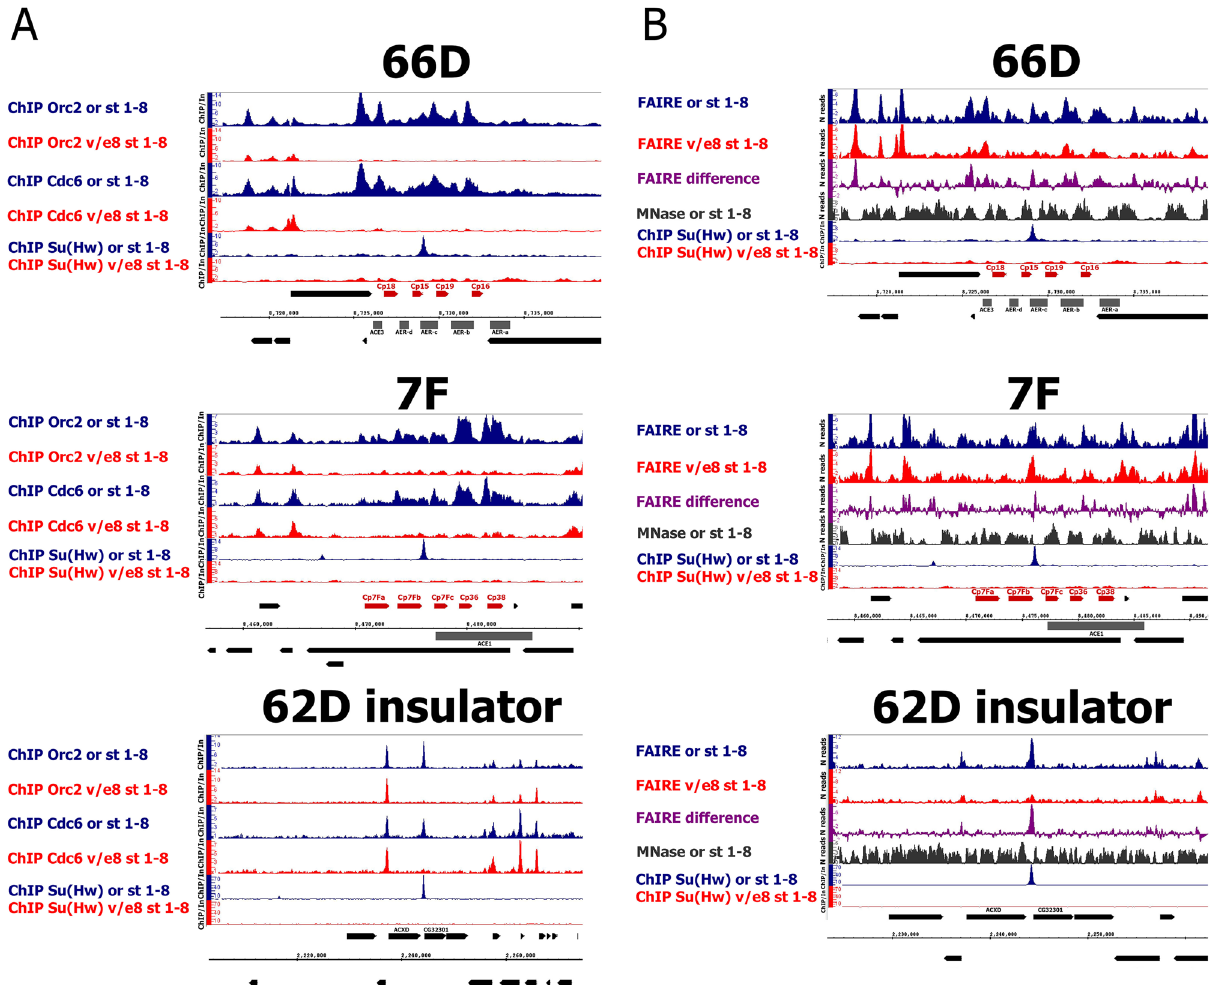
Figure 2. The absence of Su(Hw) in 66D and 7F DAFCs results in the depletion of replication proteins binding correlating with chromatin condensation at amplification regulatory regions of the loci during early oogenesis. ( A ) The binding profiles of ORC2 and CDC6 replication proteins on 66D and 7F DAFCs and on 62D insulator in the wild-type (or, blue plots) and su(Hw) v / E8 (v/e8, red plots) ovaries. Only the ovaries containing egg chambers stages 1–8 were selected for analysis. Additionally, the distributions of Su(Hw) in the wild-type (or, blue plots) and su(Hw) v / E8 (v/e8, red plots) ovaries are shown. Protein binding levels were estimated by ChIP- Seq and represent the enrichment of ChIP-Seq signal over input. The coordinates of the X-axis correspond to the dm6 version of the Drosophila genome. The coordinates of the Y-axis represent the ChIP/Input ratio. The main chorionic genes and amplification regulatory regions of the loci are marked in red and in grey, respectively. ( B ) The open chromatin profiles according to FAIRE-Seq enrichments on 66D and 7F DAFCs and on 62D insulator in the wild-type (or, blue plots) and su(Hw) v / E8 (v/e8, red plots) ovaries. Only the ovaries containing egg chambers stages 1–8 were selected for analysis. The difference between FAIRE-Seq profiles in the wild type and su(Hw) v / E8 ovaries ((FAIRE or 1–8)-(FAIRE v/e8 1–8)) is shown in violet plot. The MNase-Seq (NCBI-SRA BioProject SRP057811) for the follicular cells, extracted from the stages 1–8 of egg chambers, is shown in a black plot (described for the first time in 27 ). Additionally, the distributions of Su(Hw) in the wild-type (or, blue plots) and su(Hw) v / E8 (v/e8, red plots) ovaries are shown. The coordinates of the X-axis correspond to the dm6 version of the Drosophila genome. The coordinates of the Y-axis represent the number of reads for FAIRE-Seqs and MNase-Seq and the ChIP/Input ratio for ChIP-Seqs. The main chorionic genes and amplification regulatory regions of the loci are marked in red and in grey,